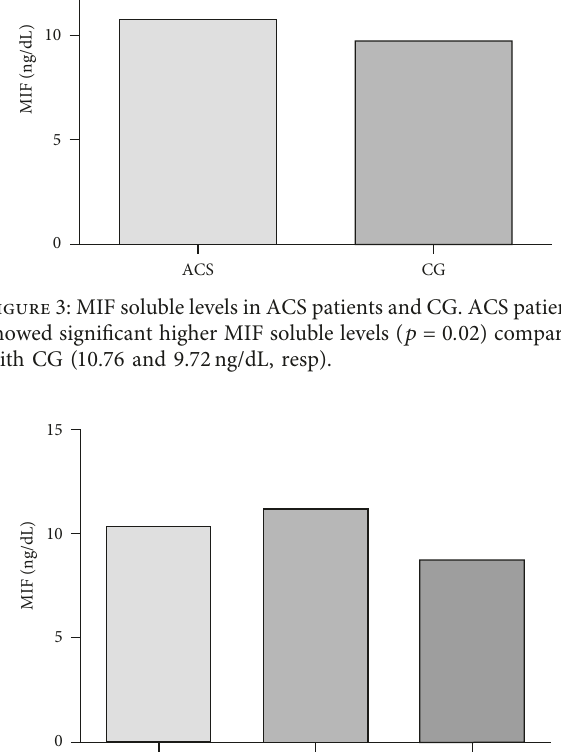
Figure 4: MIF soluble levels in the different clinical manifestation of disease. STEMI patients present the highest soluble levels of MIF (11.21ng/dL), followed by UA patients (10.34ng/dL), and finally by NSTEMI patients (8.75ng/dL). No significant difference was